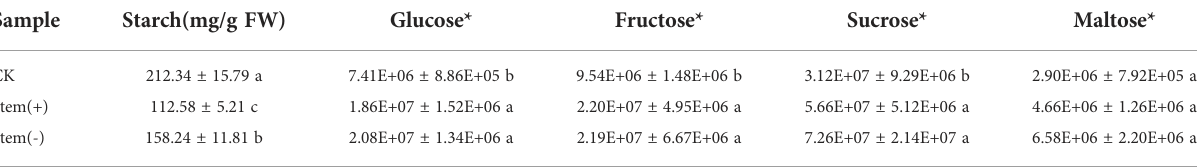
TABLE 3 Carbohydrates contents in fl ue-cured tobacco